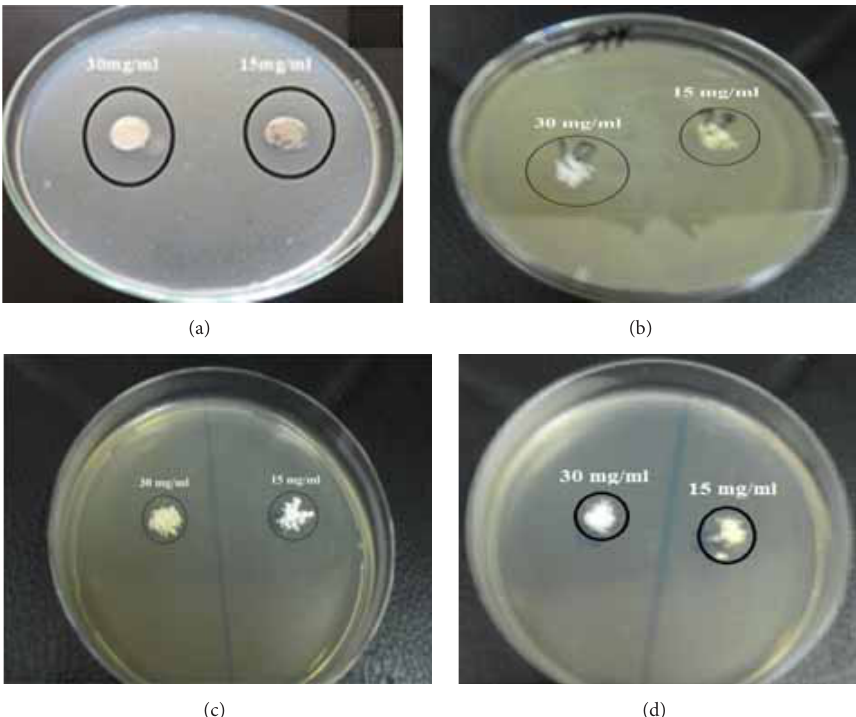
Figure 21: The influence of annealing process of zinc oxide on its antimicrobial activity against Bacillus subtilis using disc diffusion method.